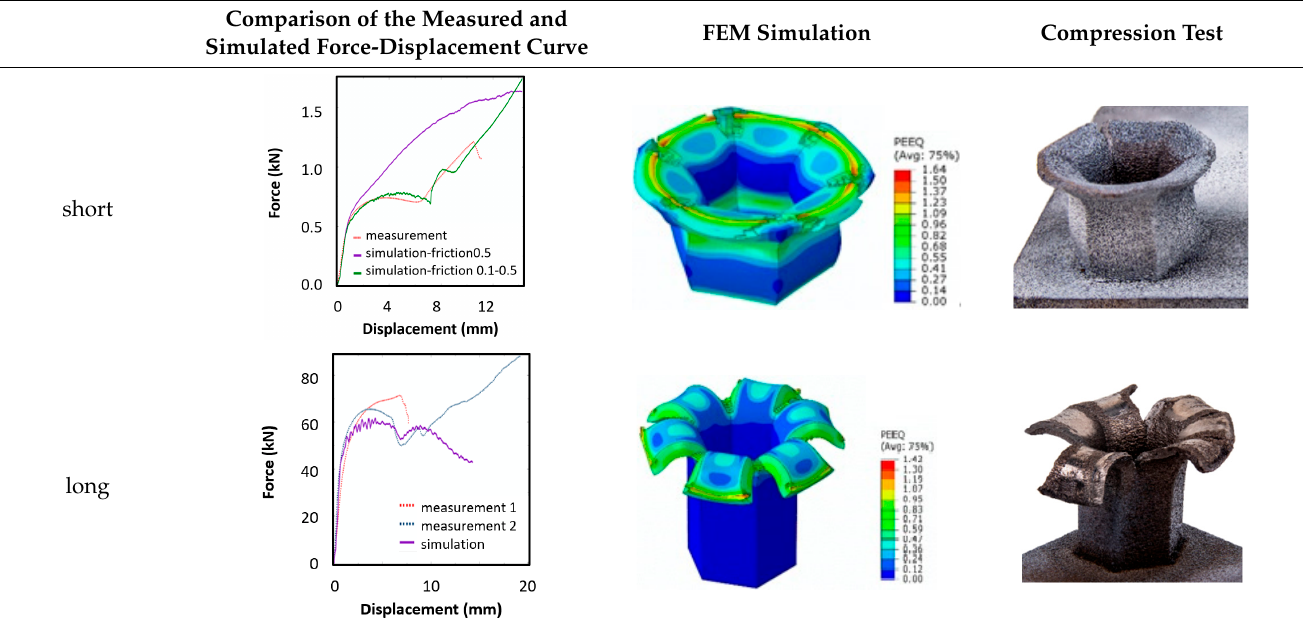
Figure 23. Comparison of SHORT structure behaviour at the end expansion phase using plastic strain distribution and total deformation evaluated by ( a ) mechanical test ( b ) FEM simulation. Based on the results of the initial numerical test without damage, a friction coefficient (Coulomb law) equal to 0.1 in the expansion phase and 0.5 during the barreling phase are the most relevant for simulation of the whole compression process. This approximation is based on the surface roughness measurement as specified in chapter 2 and the results published by Parthasarathi [48]. The view on the upper part of the honeycomb structure